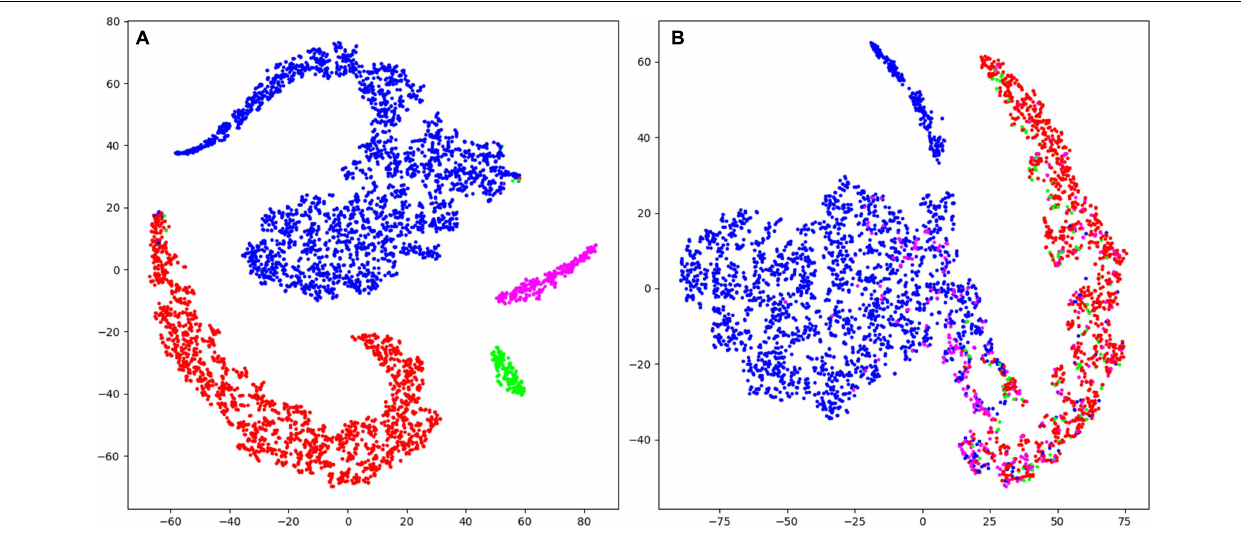
FIGURE 5 | T-distributed stochastic neighbor embedding (t-SNE) was used to illustrate the data and their classification mapped into a 2D space (last layer of the CNN 16s; arbitrary units). (A) Mapping of training data (patient Nzhl). All stages form clearly separated clusters except for very few data points as expected for the training data of artificial neural networks. (B) Mapping of validation data (patient y5We; same data as in Figure 3 ). Basically, two large clusters corresponding to W and MSE are visible which do not completely separate. MSEc and ED do not form clusters and are not separable from W and MSE. Thus, it illustrates why our algorithms could not score MSEc and ED reliably. Wakefulness (W): blue; microsleep episodes (MSE): red; microsleep episode candidates (MSEc) green; episodes of drowsiness (ED): magenta. For the convenience we illustrated only every hundredth datapoint (sample). Please note that this figure only shows the internal representation of the data in this specific network. Further data are illustrated in supporting information, for training and validation separately ( Supplementary Figures S3 , S4